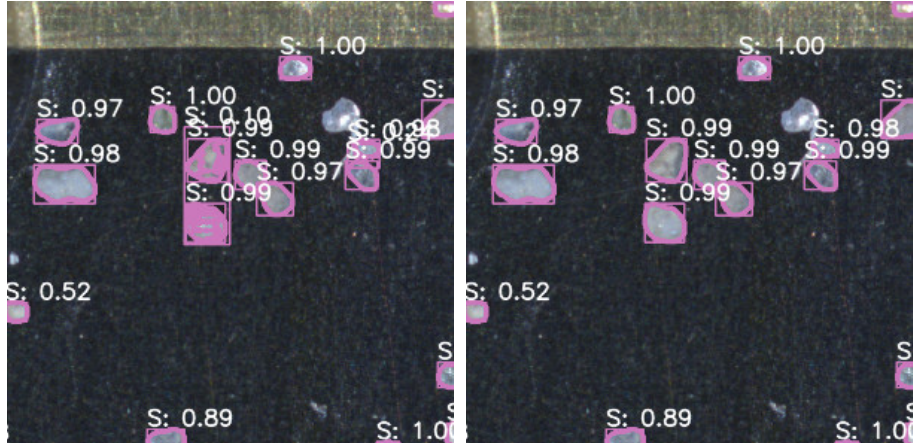
Figure A3. Additional examples of predicted bounding boxes and segmentation masks for the “sediment” class. ( Left column ): A very obvious false positive detection of the “benthic” class can be seen near the top-left corner of the first image. For the second image, several overlapping predictions can be seen. ( Right column ): The false positive detection and the overlapping predictions have been removed by thresholding the confidence score at 0.3.